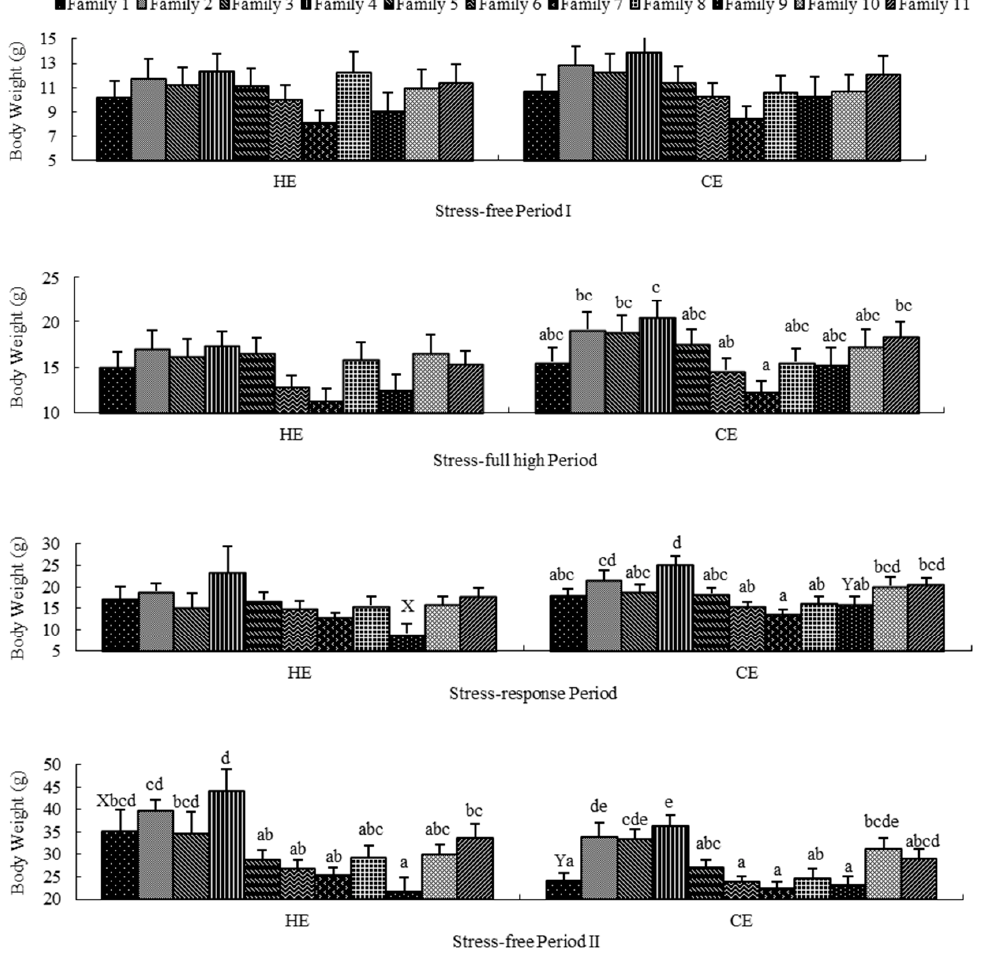
Figure 2. Ranking of families for body weight in high temperature and control temperature environments. The histogram bar indicates mean and standard error in each separate family. In each environment, lower-case letters (a,b,c,d,e) indicate significant differences between families ( p < 0.05), and upper-case letters (X,Y) indicate significant differences between environments ( p < 0.05).